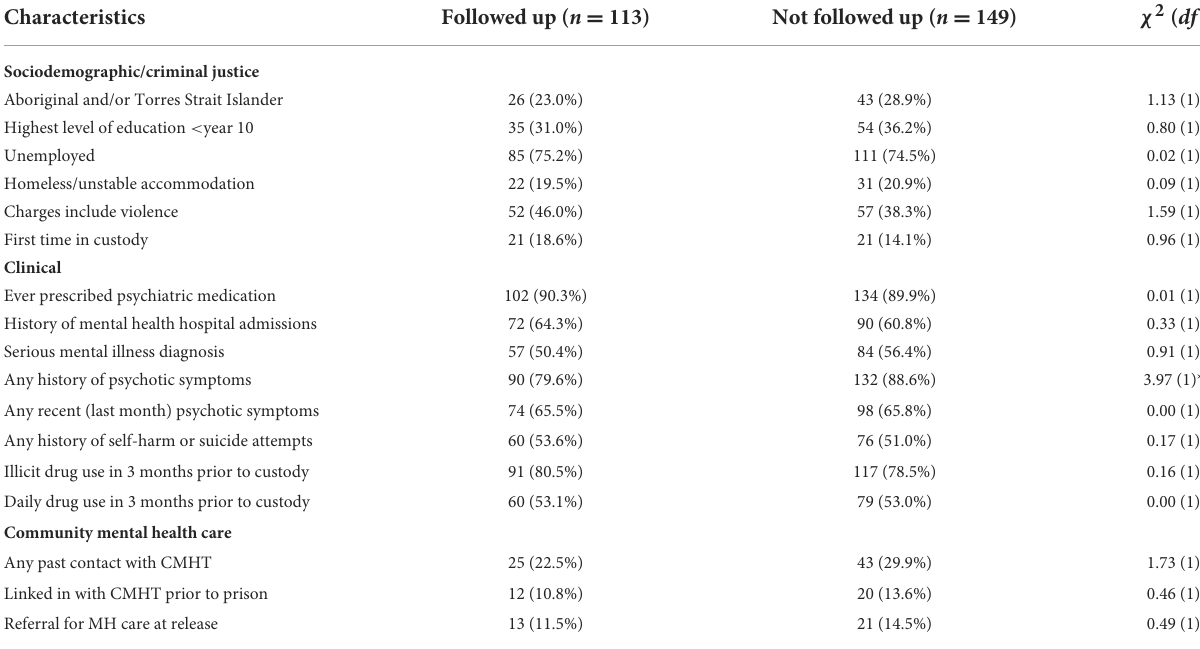
TABLE 3 Comparison of baseline characteristics of participants followed up by the research team at 3 months post release with those lost to follow-up. Characteristics Followed up ( n =